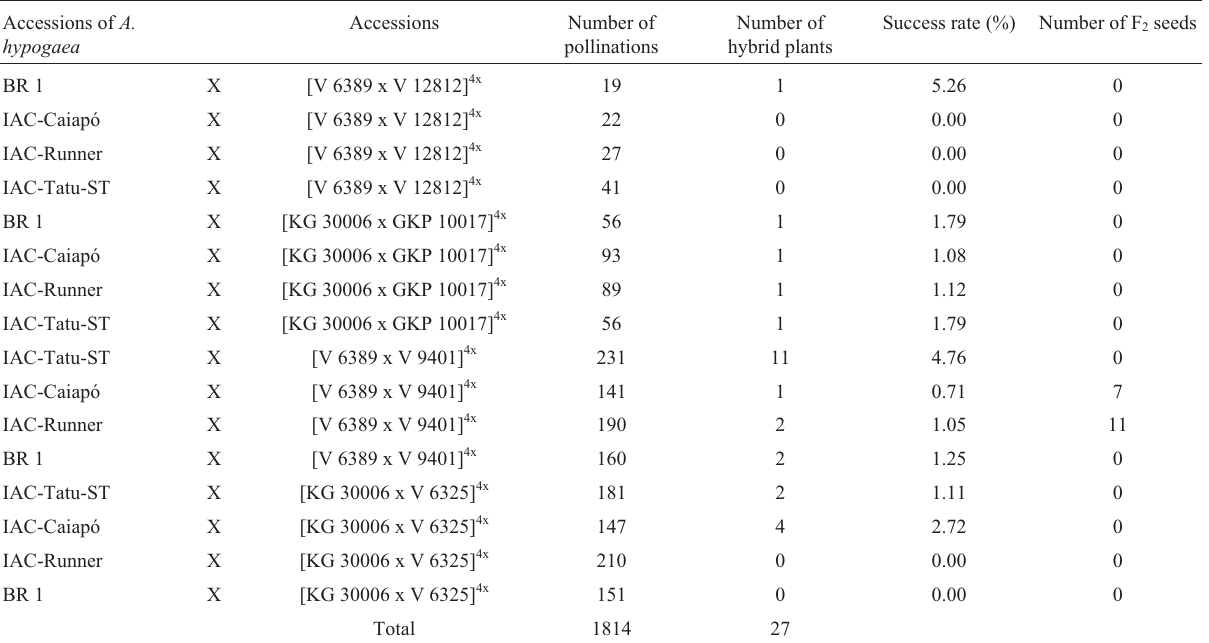
Table 3 - Crosses between Arachis hypogaea accessions and the synthetic amphidiploids, the number of pollinations achieved, number of hybrid plants obtained, success rate, and number of F 2 seeds. Accessions of A.